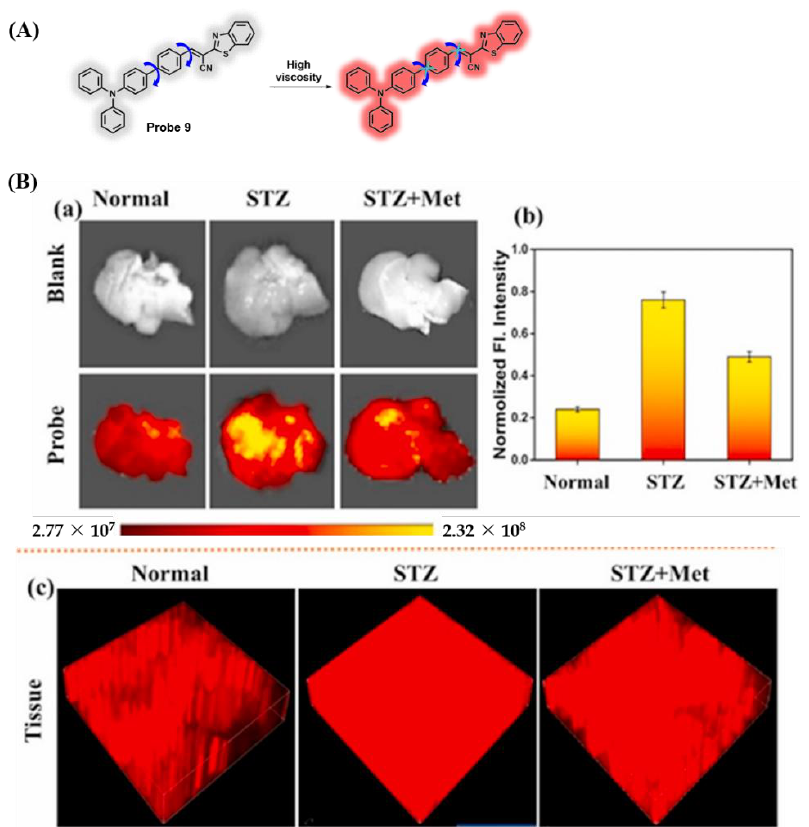
Figure 7. ( A ) Imaging mechanism of probe 9 ; ( Ba ) fluorescence imaging of LDs viscosity with probe 9 (15 µ M) in normal, STZ-induced, and Met-treated livers/liver slices; ( Bb ) fluorescence intensity of ( Ba ); ( Bc ) fluorescence images of the normal, STZ-induced and Met-treated liver slices pretreated with probe 9 , λ ex / em = 520/650 nm. Adapted from Reference [63]. Copyright 2021, Elsevier